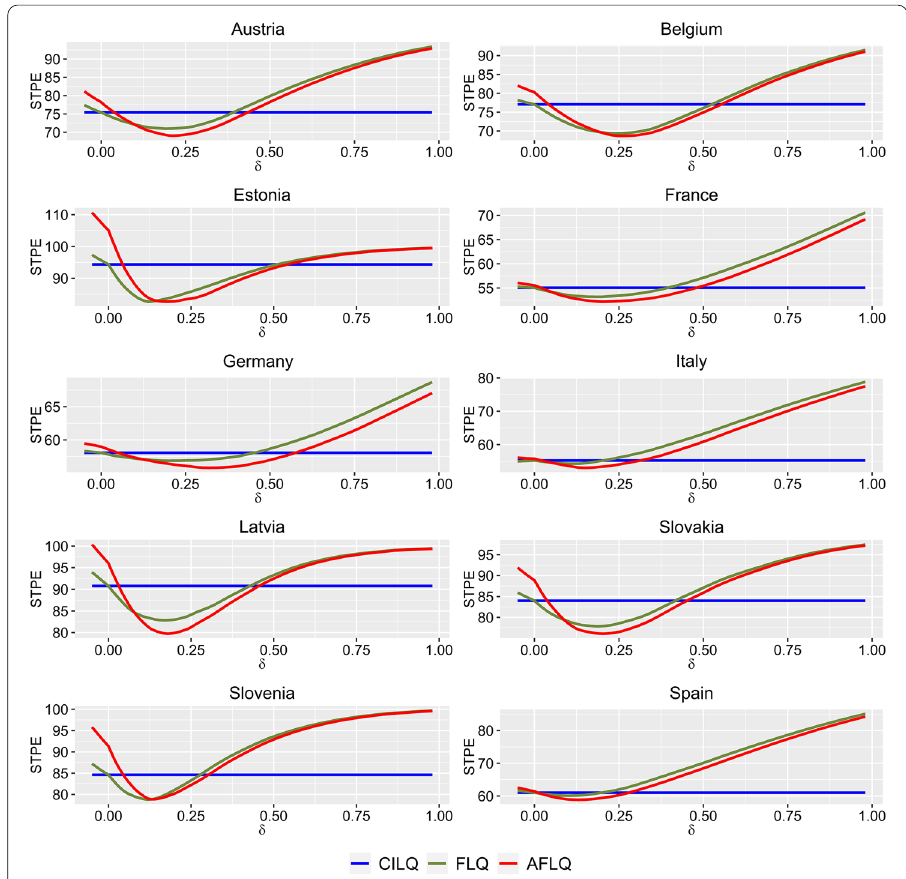
Fig. 2 Sensitivity analysis using STPE for ten EA‑19 countries in